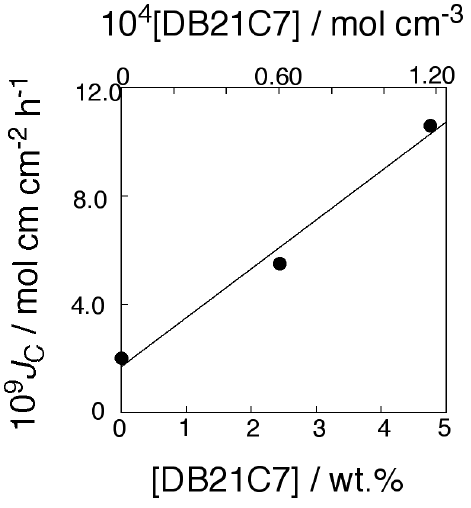
Figure 9. Relationship between CsCl flux and the DB21C7 concentration through the PC18AAm liquid membrane (Operating temperature, 50 °C (323 K); [CsCl] = 1.0 × 10 − 4 mol·cm − 3 0